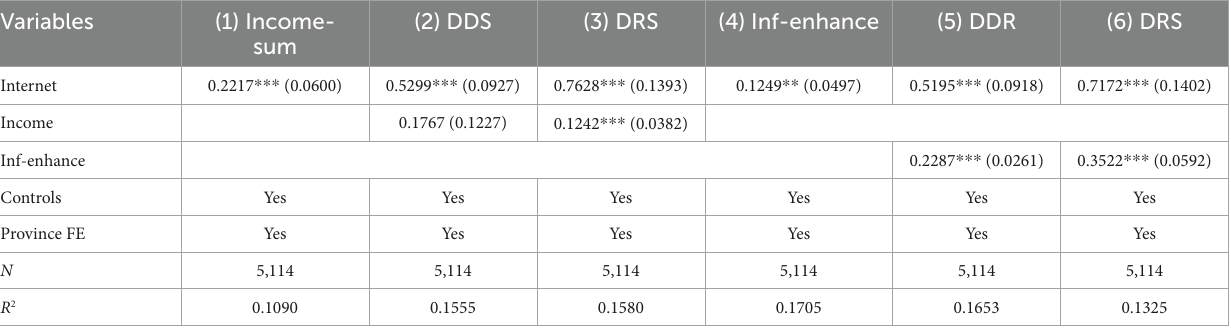
TABLE 9 Results of mechanisms analysis of the impact of Internet use on smallholder diets.